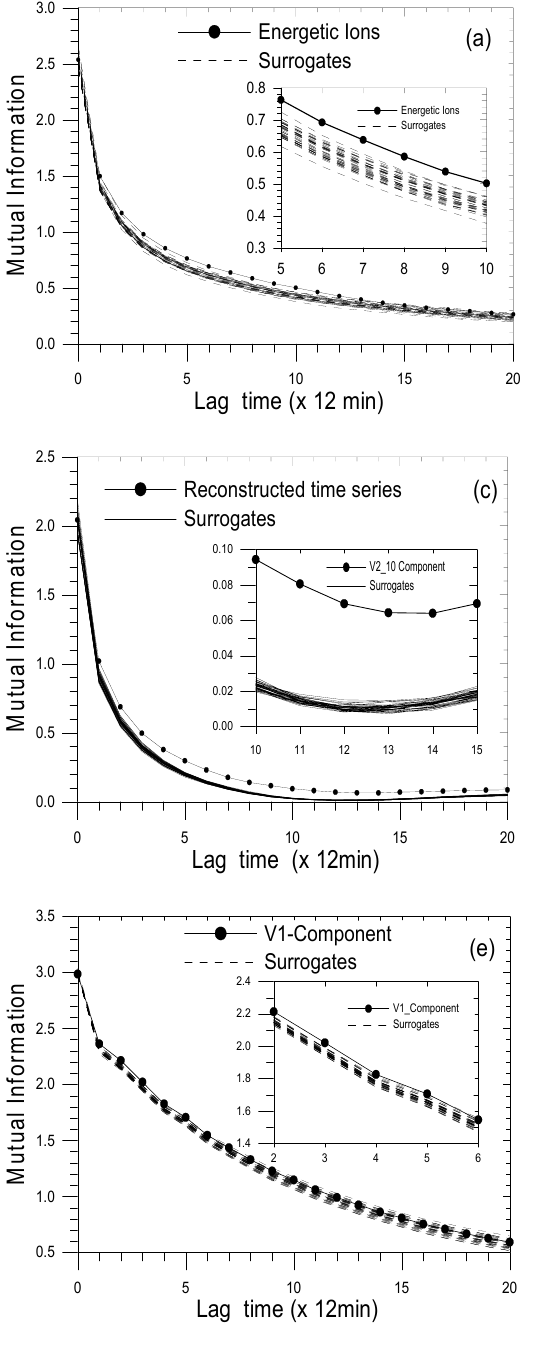
Figure 6 Fig. 6. (a) Mutual information estimated for the energetic ions’ time series and its surrogate data as a function of the lag time. (b) The significance of the discriminating statistic of the mutual information as a function of the lag time shown in (a). (c, d) The same with (a, b) but for the reconstructed time series. (e, f) The same with (a, b) but for the V 1 -component time